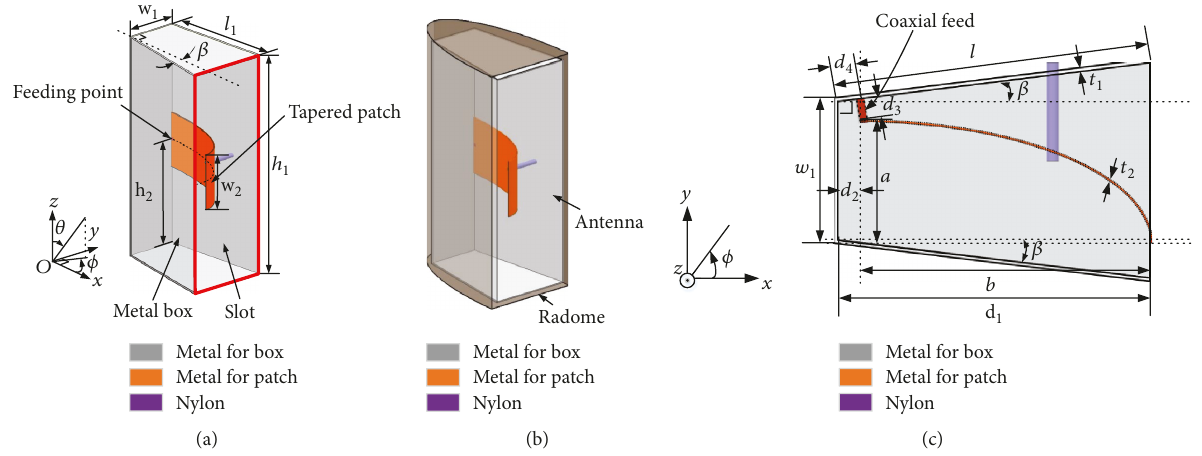
Figure 1: The structure of a wideband HP quasi-omnidirectional antenna: (a) perspective view; (b) package with a radome of blade shape; (c) top view.